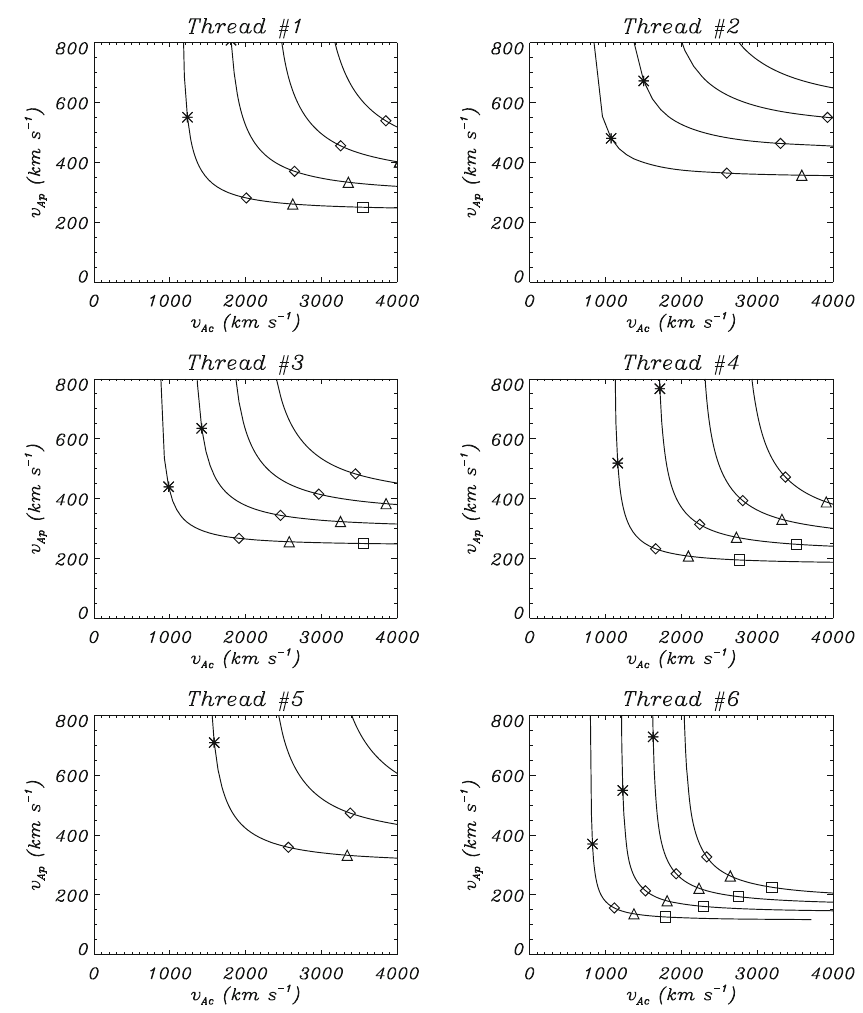
Fig. 90 Dependence of the Alfvén velocity in the thread as a function of the coronal Alfvén velocity for the six threads observed by Okamoto et al. (2007). In each panel, from bottom to top, the curves correspond to a length of magnetic field lines of 100,000, 150,000, 200,000 and 250,000 km, respectively. Asterisks, diamonds, triangles and squares correspond to density ratios of the thread to the coronal gas ζ (cid:8) 5 , 50 , 100 , 200. Image reproduced with permission from Terradas et al. (2008), copyright by